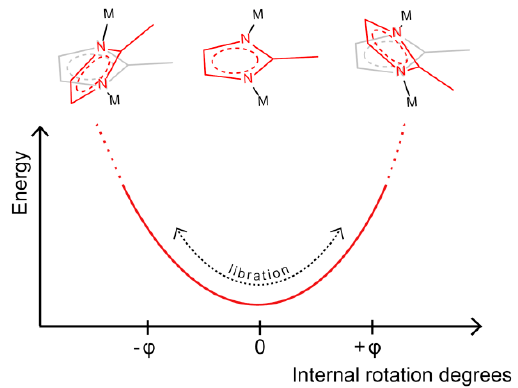
Figure 11. Illustration of the torsional potential for coordinated imidazolate linkers (as in zeolitic imidazolate frameworks (ZIFs)). Large amplitude rotations are hampered by the connectivity angle, yet small-amplitude librations are possible.